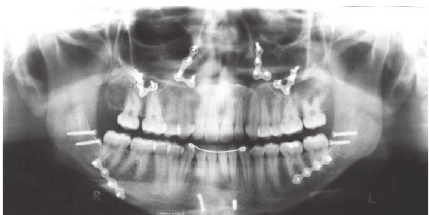
Figure 8: Posttreatment panoramic